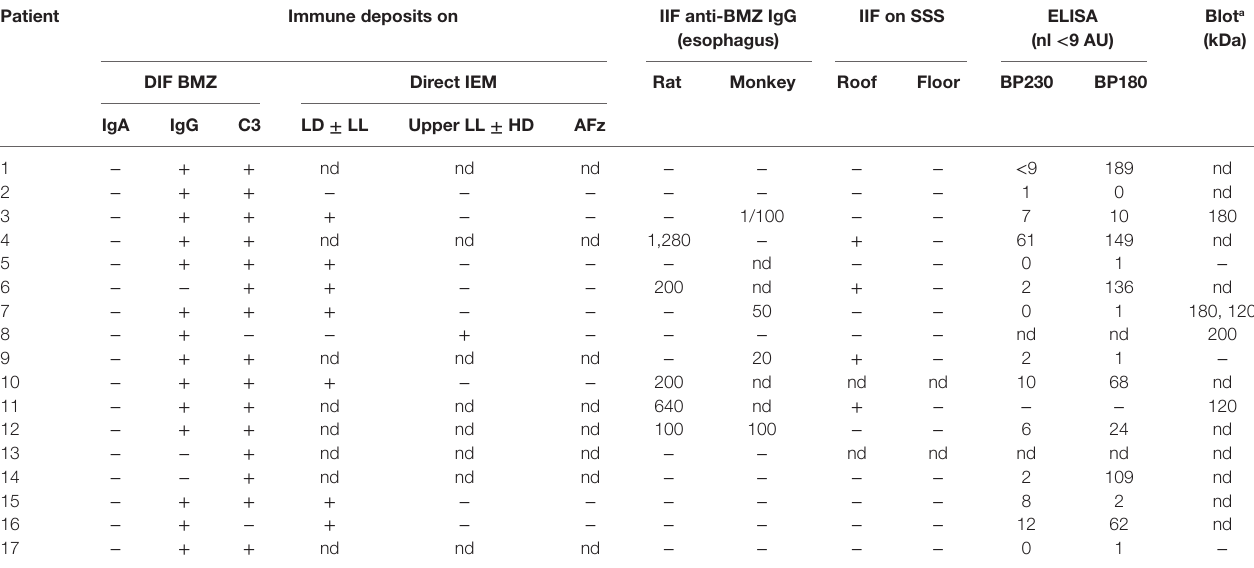
Table 2 | Immunological findings of the 17 gliptin-treated MMP patients with suggestive-or-compatible challenges.